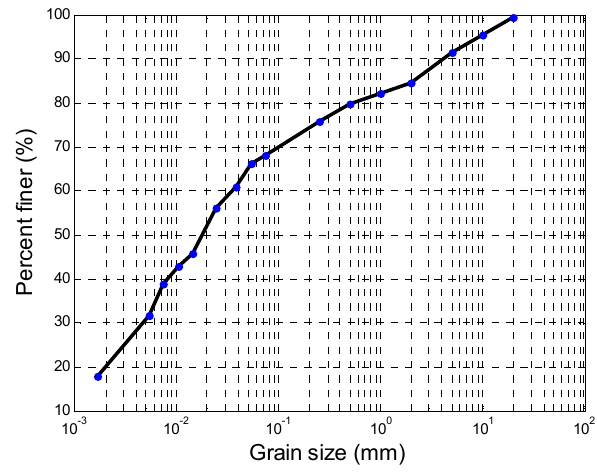
Figure 1. Grain-size distribution of test materials.